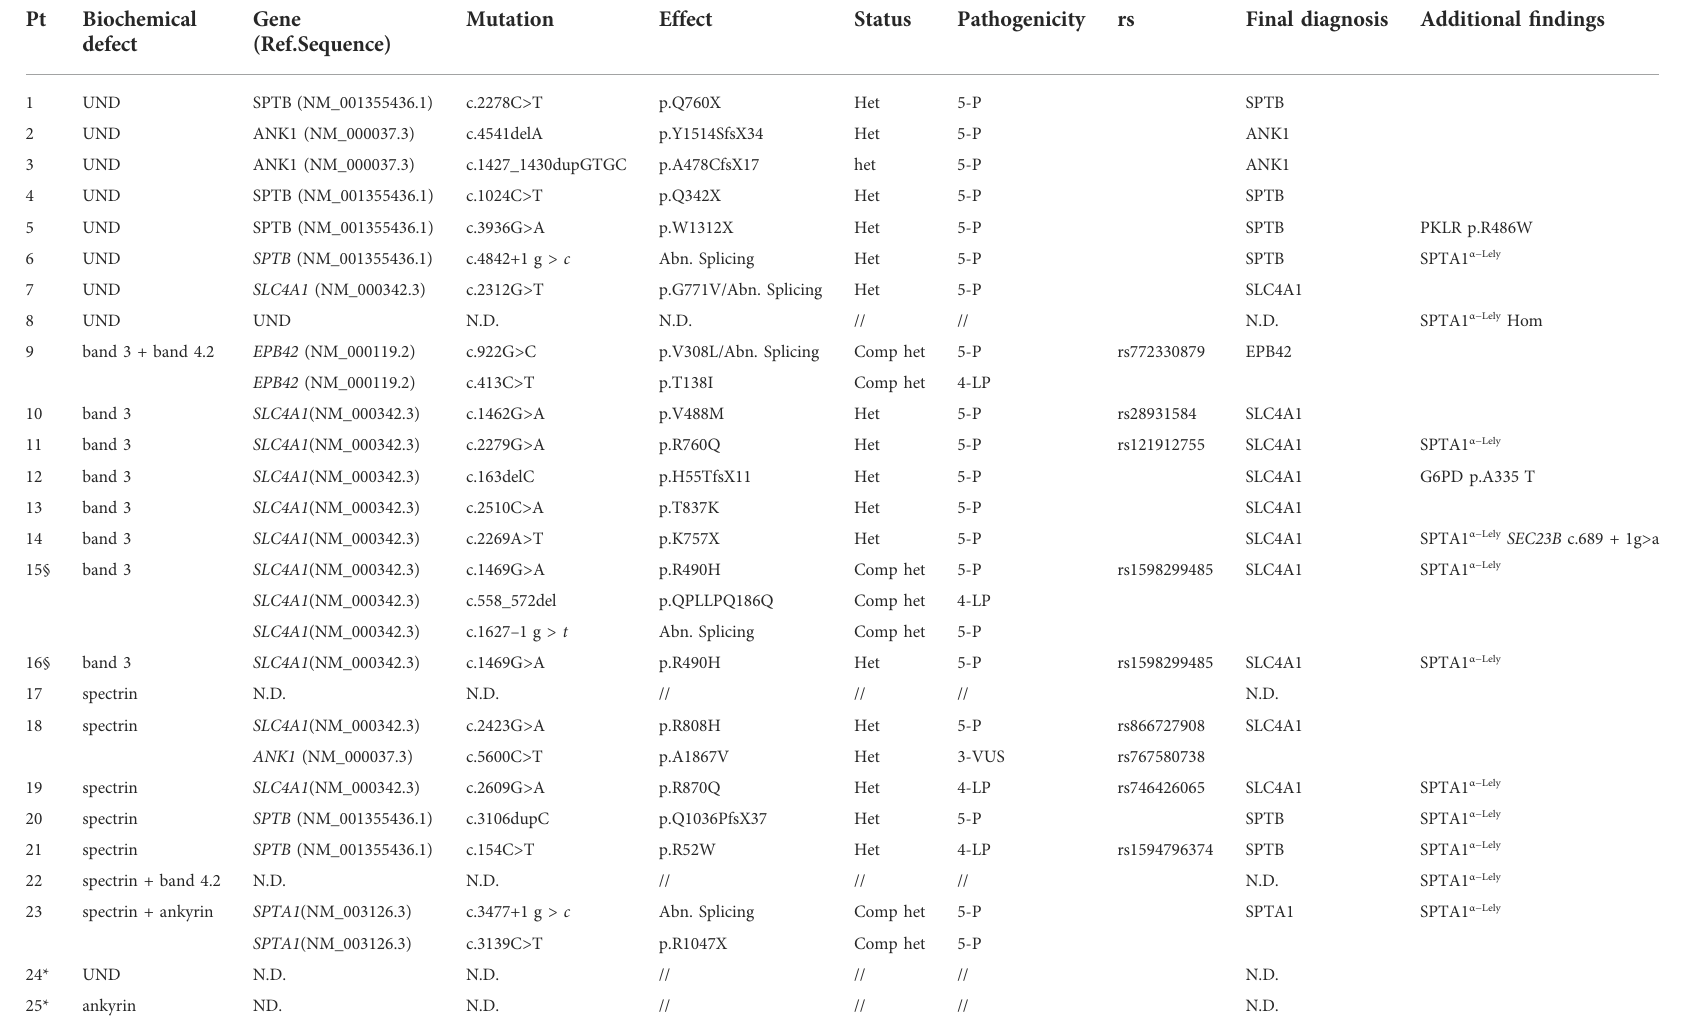
TABLE 2 Results of NGS